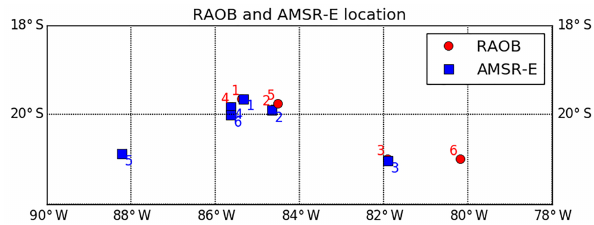
Figure 3. The map of the six collocated RAOB and AMSR-E mea- surements in the VOCALS campaign. The spatial and temporal dif- ferences for all six cases are listed in the Table